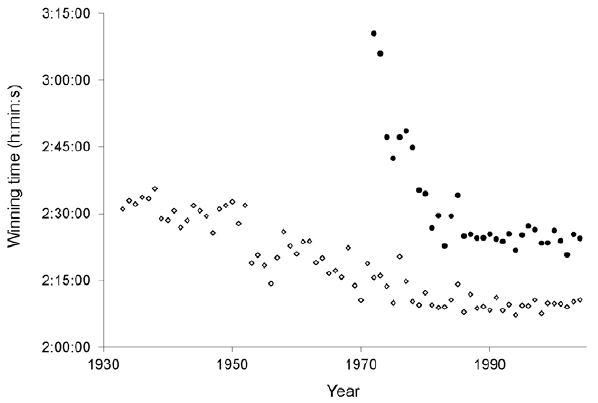
Figure 2. Winning marathon times over the history of the Boston Marathon. Open diamonds represent men’s times from 1933– 2004. Closed circles represent women’s times from 1972–2004. Women’s running times improved rapidly in the first 14 yr of women’s participation in the marathon. From 1983 to 2004, the differences between men and women’s winning times held relatively constant at an average of 15 min 47 s.